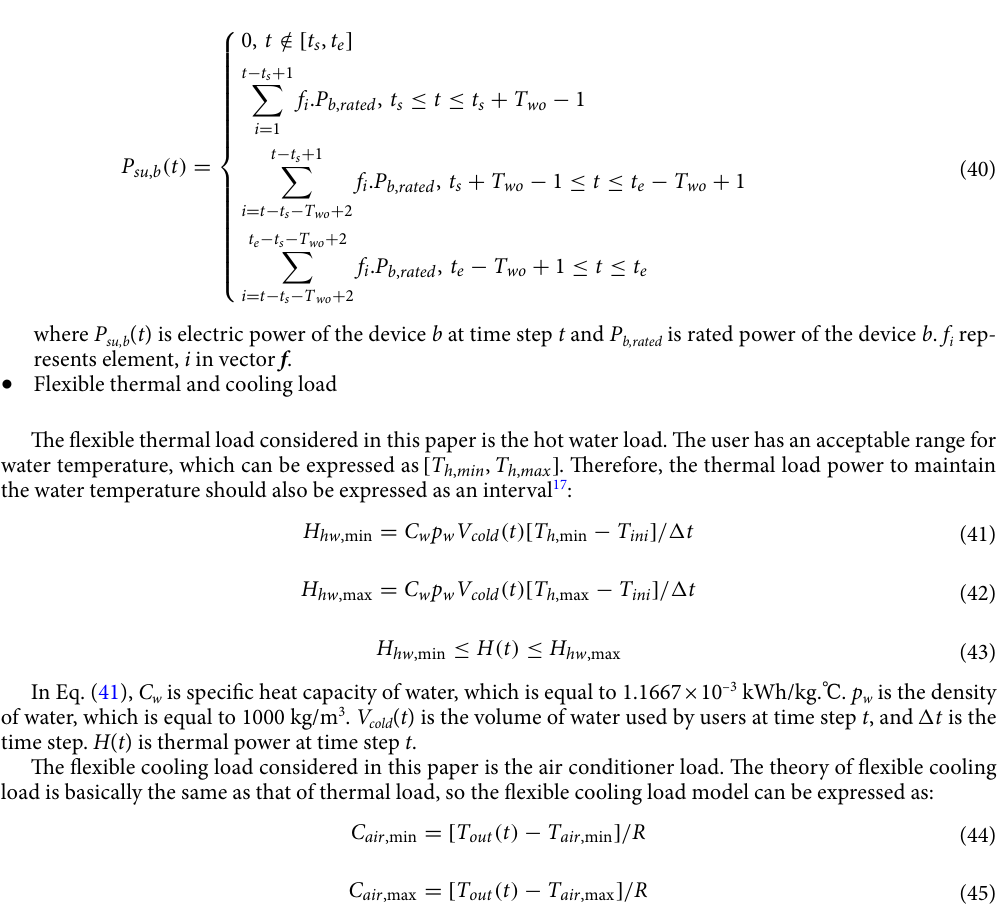
Table 2. 16 . As for EV, the users arrive home at 18:00 and leave home at 8:00, and the surplus electricity at 18:00 is 1kWh, and the expected electricity at 8:00 is 24kWh, and the loss factor is 0.01, and the charging efficiency is 0.95, and the maximum charging power is 3.6 kW. Flexible thermal load considered in this paper is hot water load, and flexible cooling load is air conditioner load. The acceptable range for hot water temperature [ T h , min , T h , max ] is [65,75]. The acceptable range for indoor temperature [ T air , min , T air , max ] is [22,26]. In multistep carbon trading cost model, p is 44 $/t, ω is 0.2, v is 30 t and µ is 0.25. Electricity price is shown in Table 3.